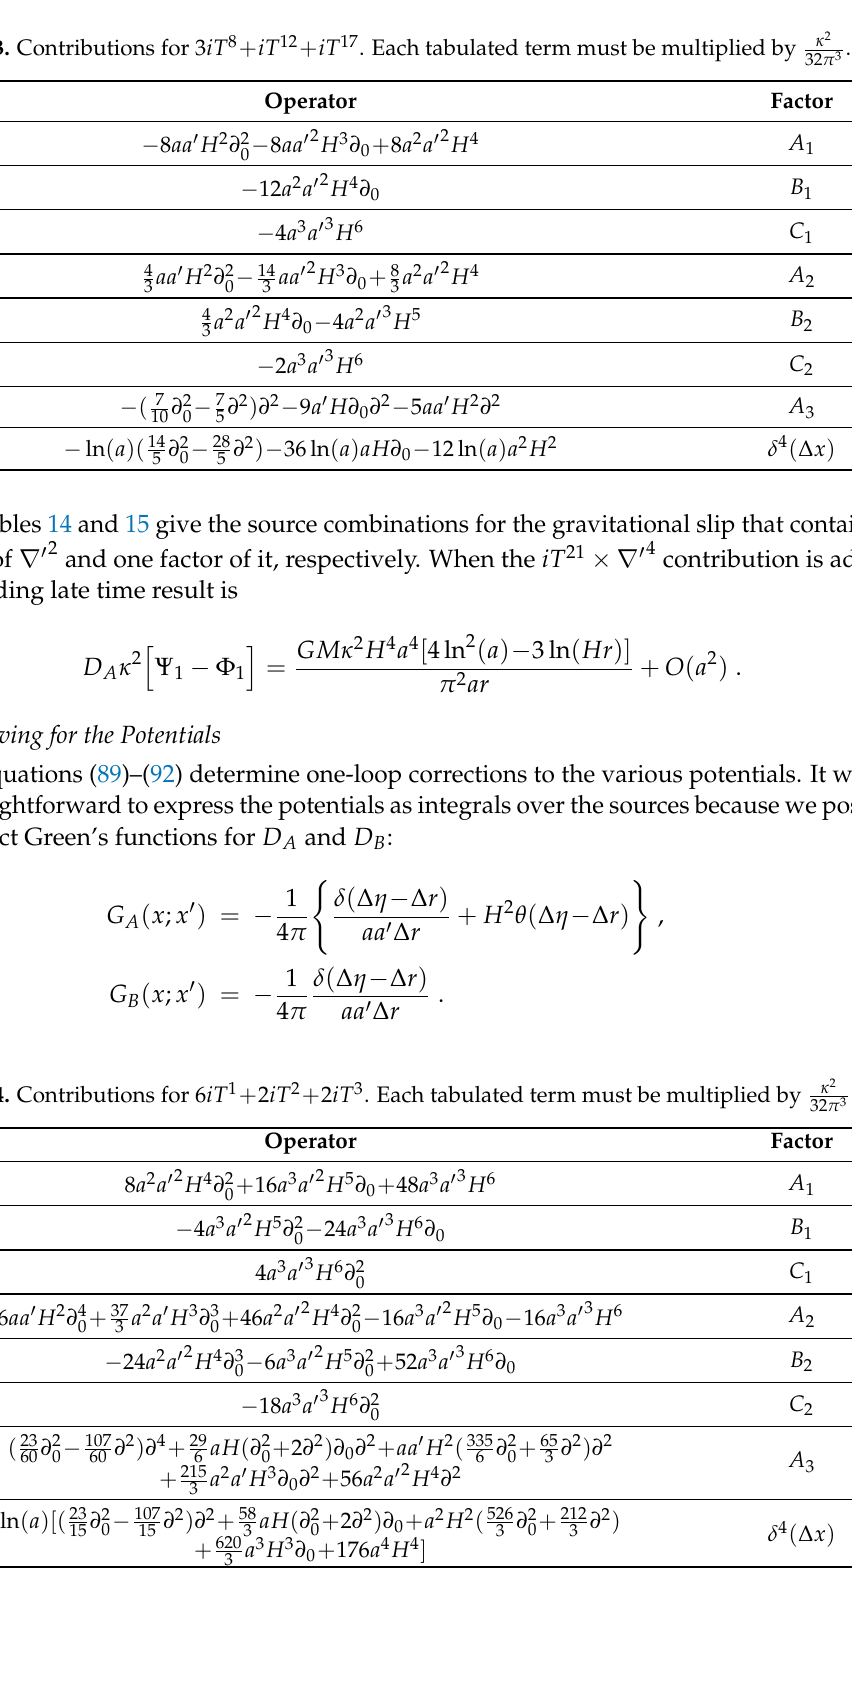
Table 13. Contributions for 3 iT 8 + iT 12 + iT 17 . Each tabulated term must be multiplied by κ 2